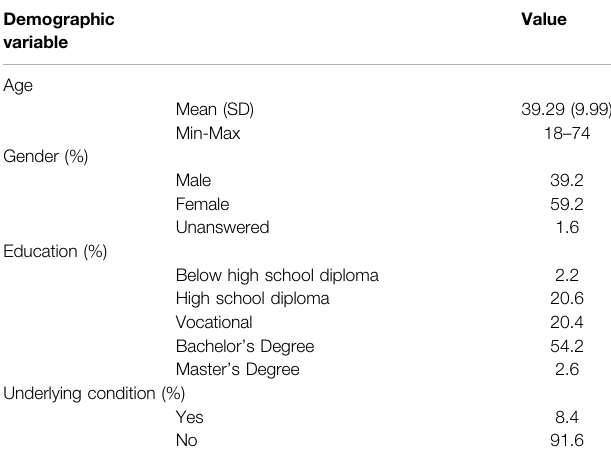
TABLE 1 | Demographic information of the